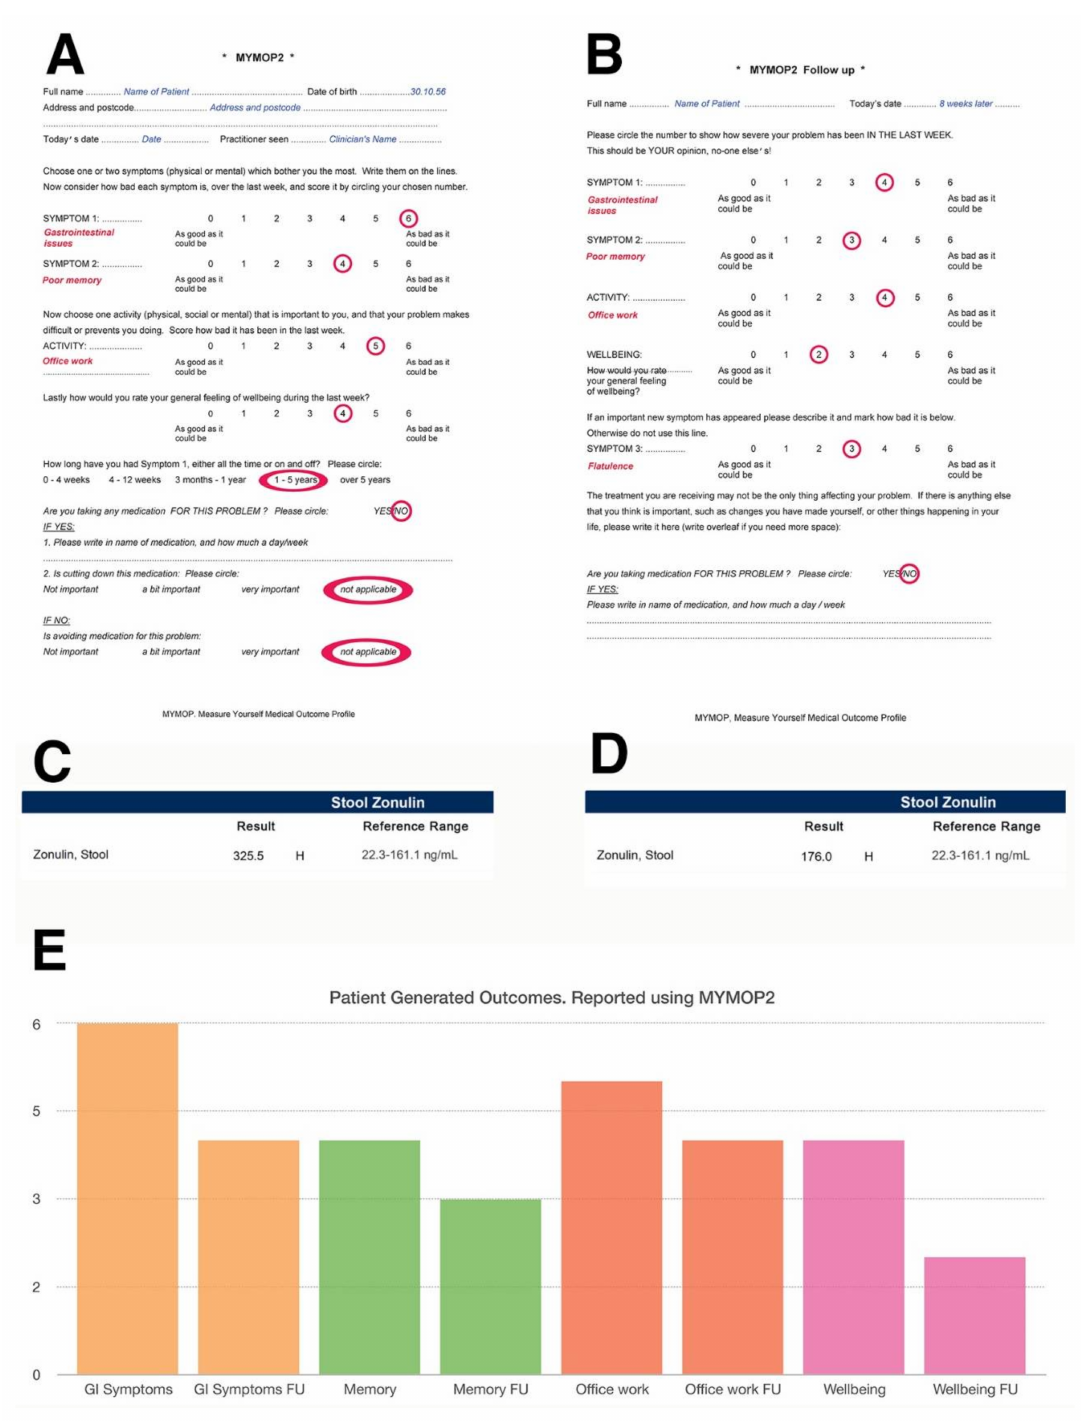
Figure 4. An example of how the MYMOP (Measure Yourself Medical Outcome Profile) questionnaires can be used in clinical practice as a means to assess the effectiveness of interventions. This validated data collection tool is patient-centred and combines qualitative (symptom-based) and quantitative (scoring) data. ( A ) Represents an example of initial MYMOP questionnaire. ( B ) Represents a MYMOP follow-up questionnaire administered eight weeks after the initial one. ( C , D ) Represent an example of a marker showing a change as a result to the intervention. ( E ) Represents an example of how data can be organised and displayed using spreadsheet software, e.g., Excel (Microsoft) or Numbers (Apple Inc.), with FU standing for “follow up” in the bar